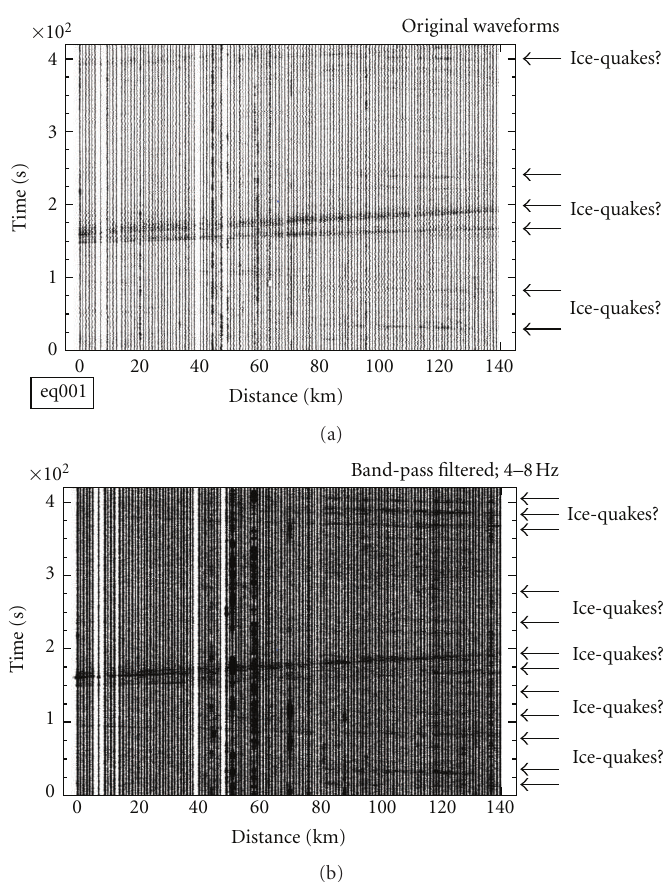
Figure 10: (upper) original waveforms for record section of local events, which appeared to be ice related events (ice-quakes) (event#; eq001). (lower) Band-pass filtered (4.0–8.0 Hz) waveforms of the same record section. A significant number of local (ice-related) events are raveled as